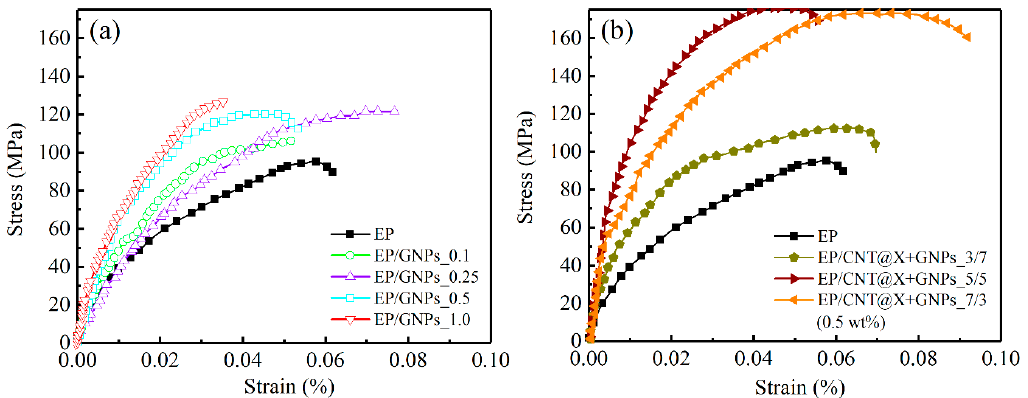
Figure 10. Dynamic compressive stress–strain curves of the ( a ) EP/GNPs and ( b ) EP/CNT@X+GNPs nanocomposite specimens under a strain rate of 500/s.